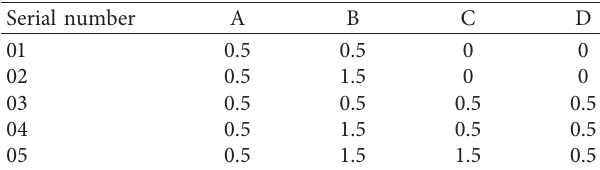
Table 4: Initial preset cracks of two-hole specimen with variable amplitude.